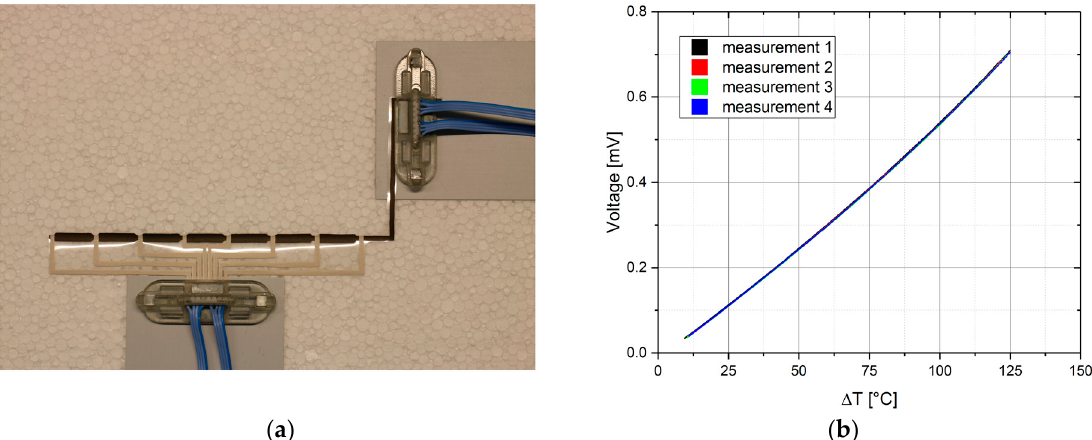
Figure 1. ( a ) Thermocouple array consisting of one line carbon black which is crossed by eight lines of silver printed on PET-foil; ( b ) Thermocouple output recorded over four subsequent measurements up to a junction temperature of 150 °C while the terminal was kept at 25 °C resulting in a temperature difference ∆ T of 125